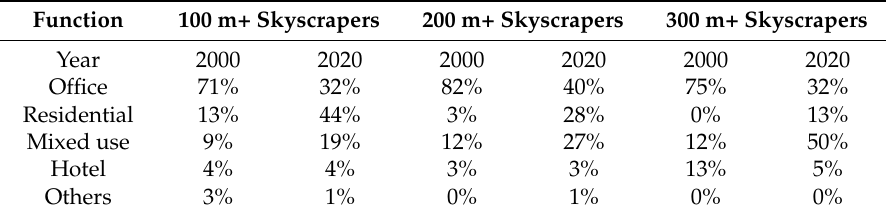
Table 35. Changing functional use of skyscrapers in 2000 and